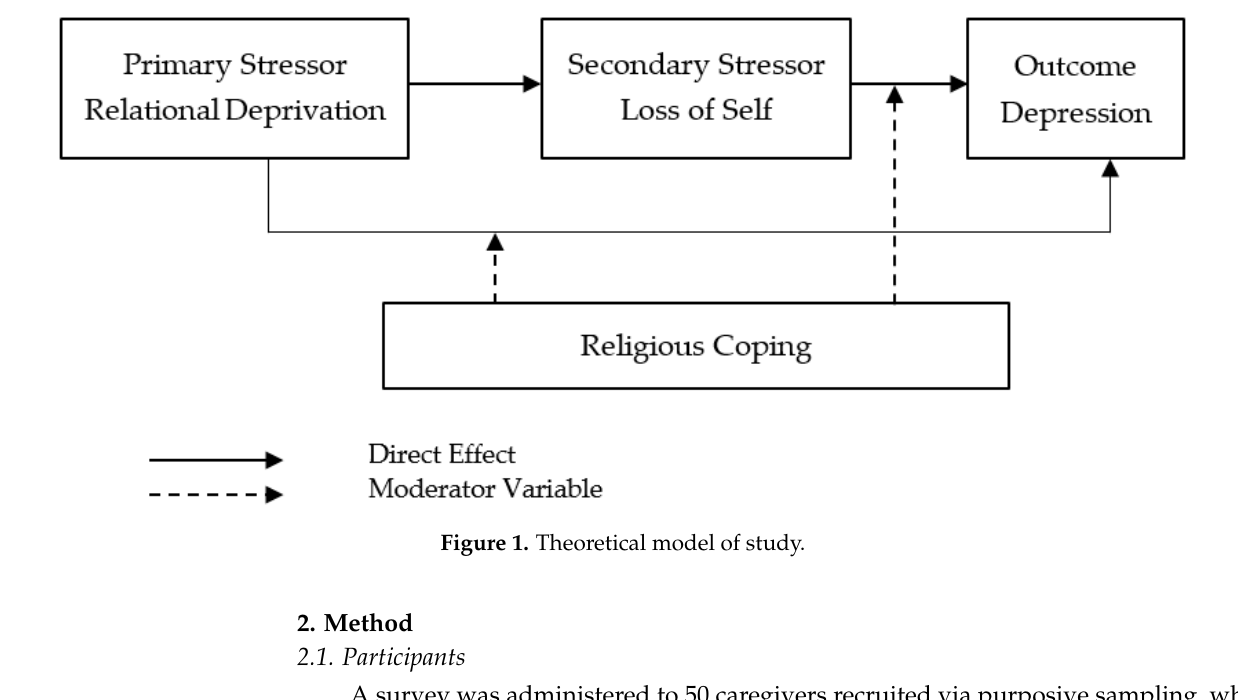
Figure 1. Theoretical model of study.